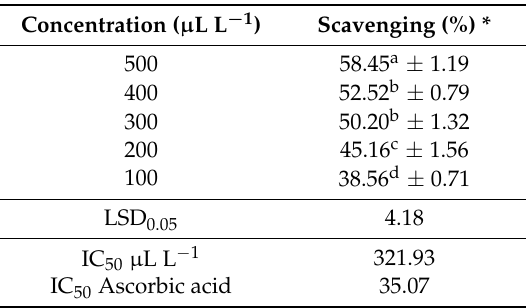
Table 4. Antioxidant activity of the EO from Egyptian X. strumarium and ascorbic acid as